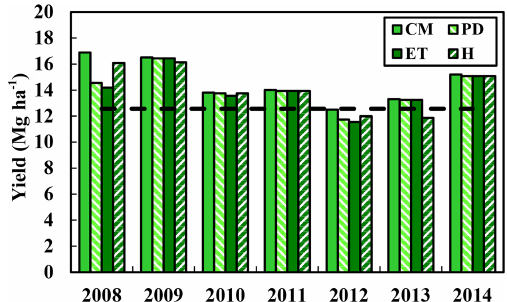
Figure 7. Potential yield simulated by Hybrid-Maize using the four irrigation routines: crop model (CM), precipitation delayed (PD), evapotranspiration replacement (ET), and Hydrus-1D